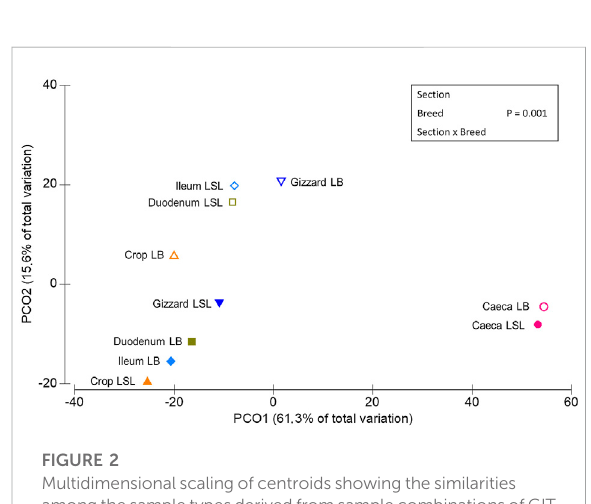
FIGURE 2 Multidimensionalscalingofcentroidsshowingthesimilarities amongthesampletypesderivedfromsamplecombinationsofGIT section x